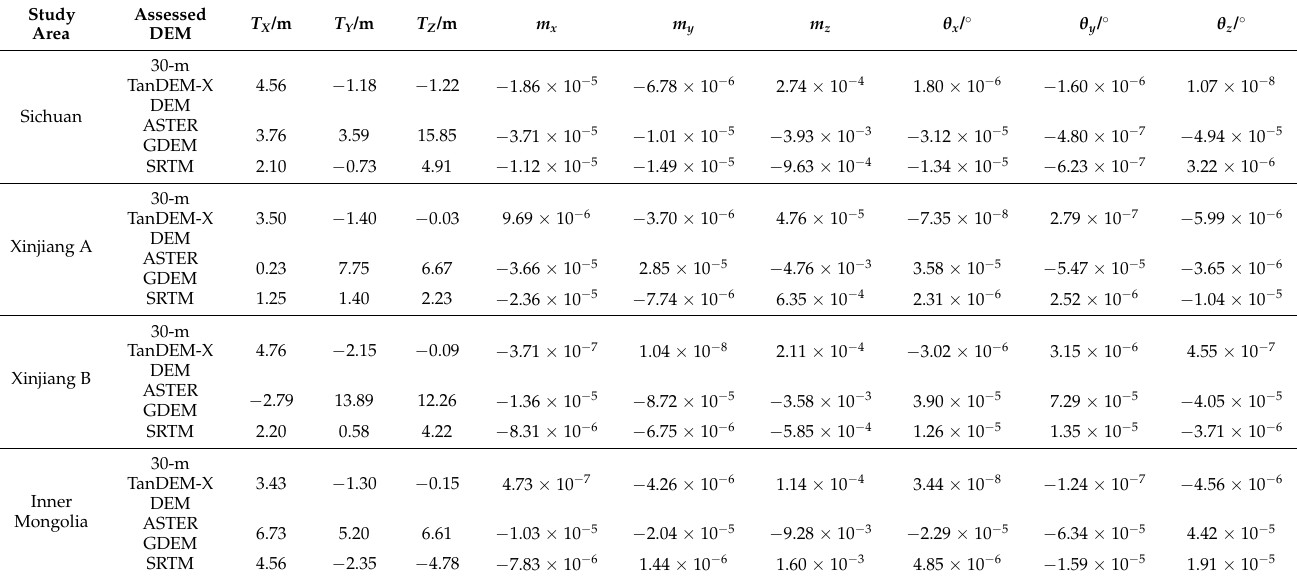
Table 4. Statistics of nine transformation parameters used in co-registration between the assessed DEMs and the reference DEM.